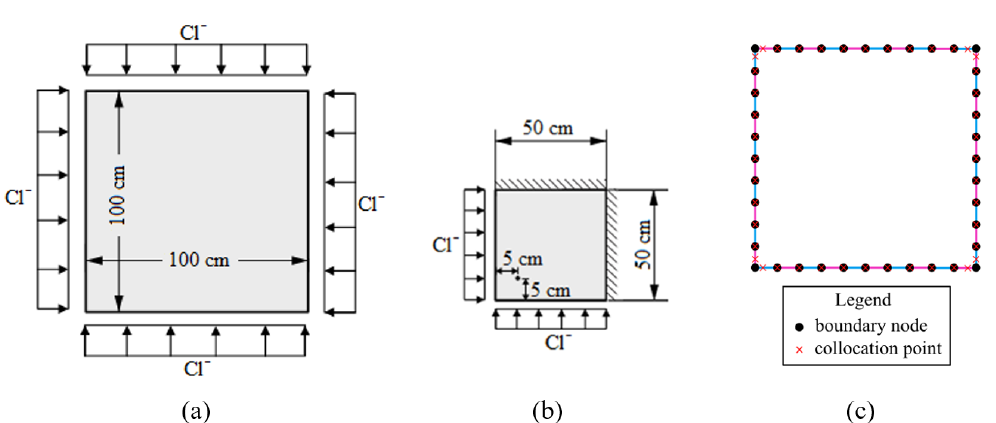
Figure 2. (a) Cross-section geometry and boundary conditions, (b) Symmetry boundary conditions, (c) BEM mesh.